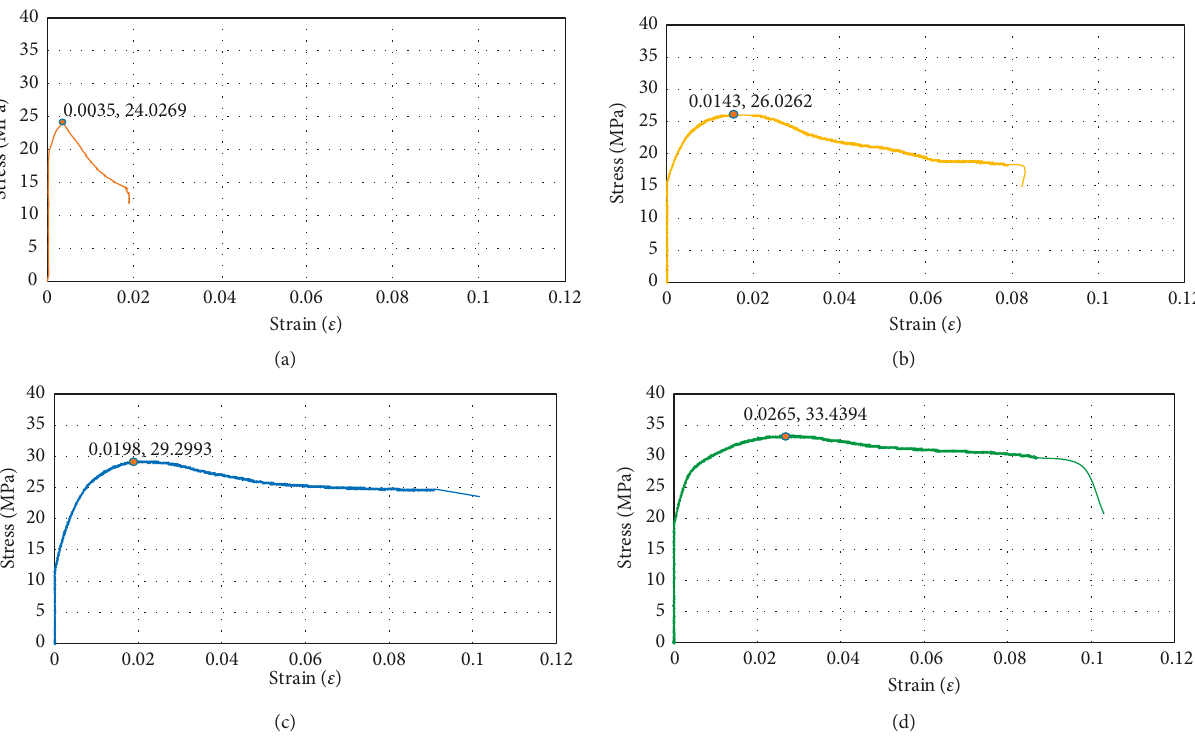
Z m1 (cid:31) 28.625),